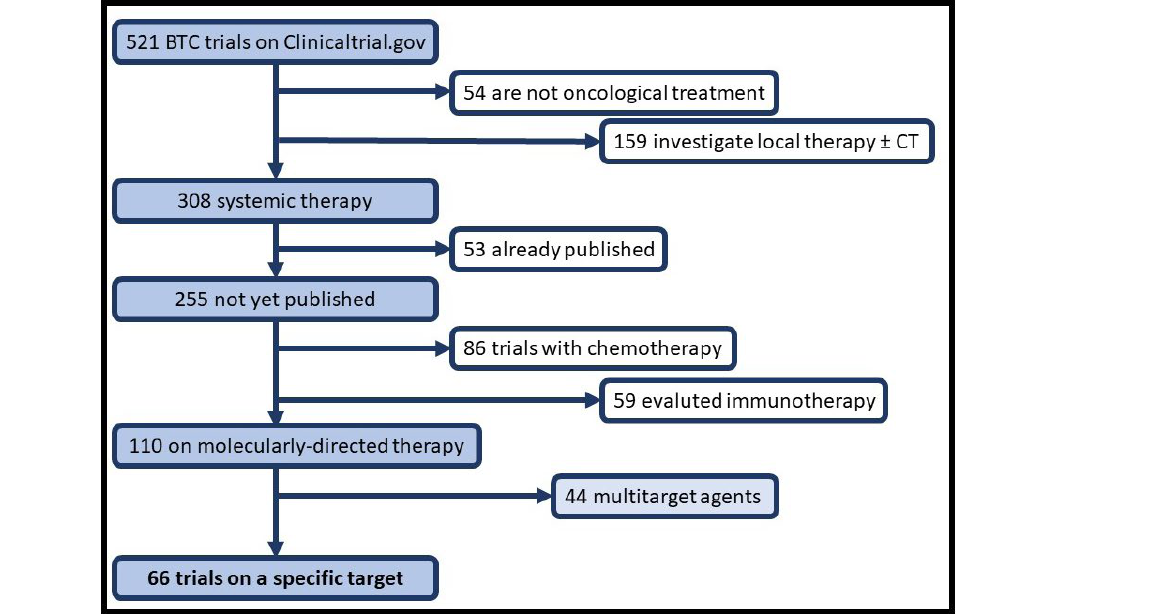
Figure 1. Flowchart from trials available on clinicaltrials.gov. CT: computed tomography Targeting